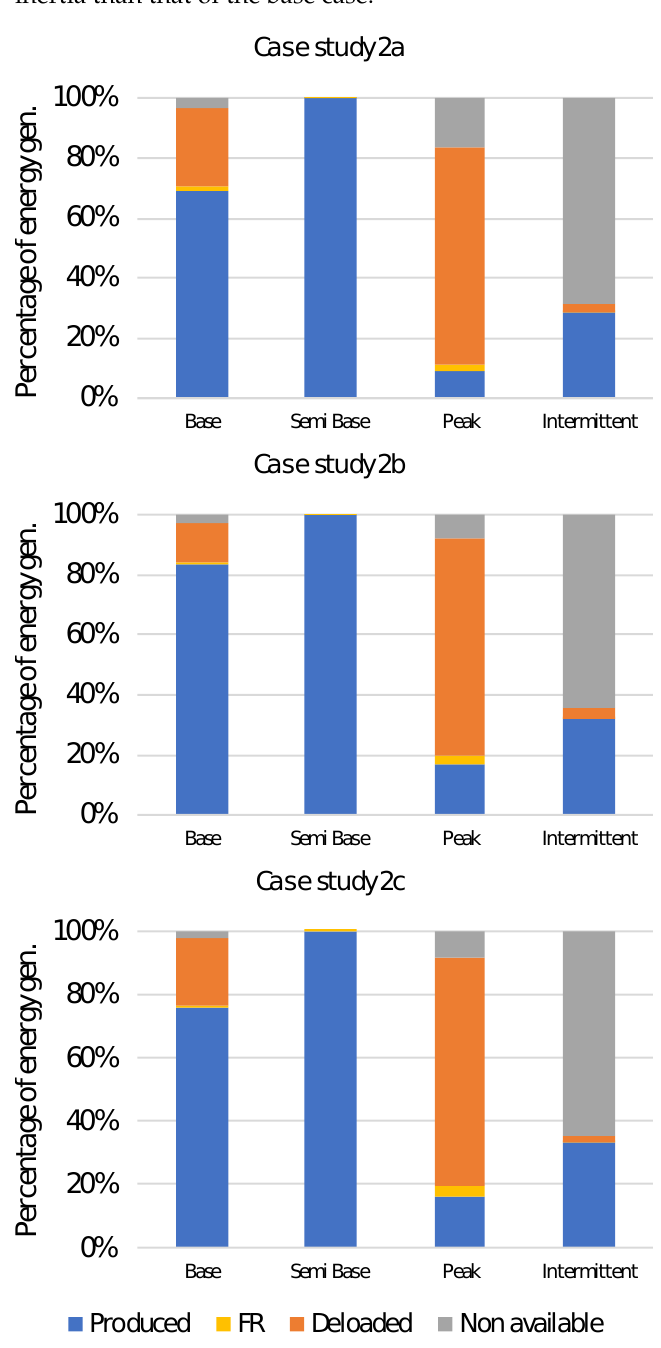
Figure 11. Energy breakdown per technology type for Case study 2. When gas is replaced by offshore wind (i.e., cases 2b and 2c), a greater demand for flexibility (due to a higher de-loading) is also observed for the nuclear fleet than in